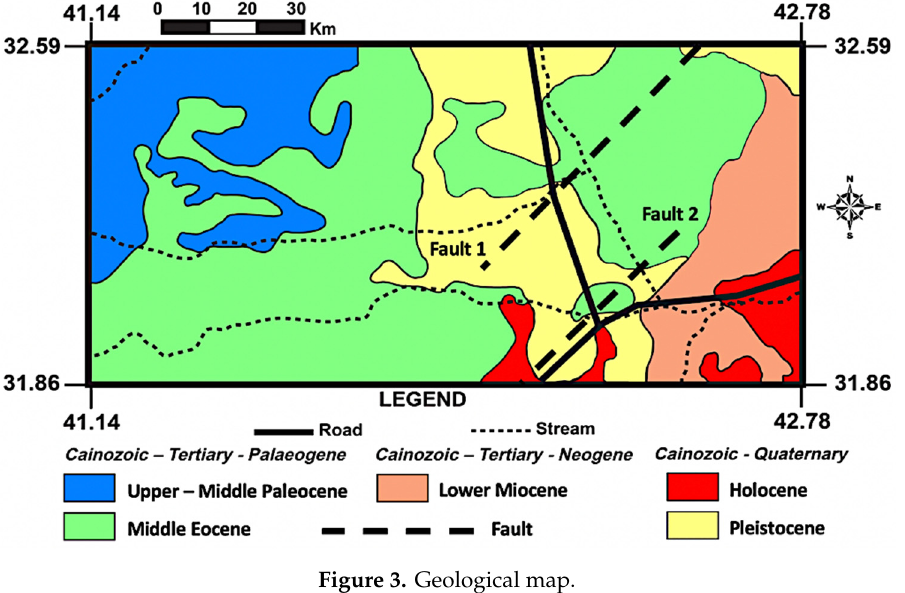
Figure 3. Geological map.